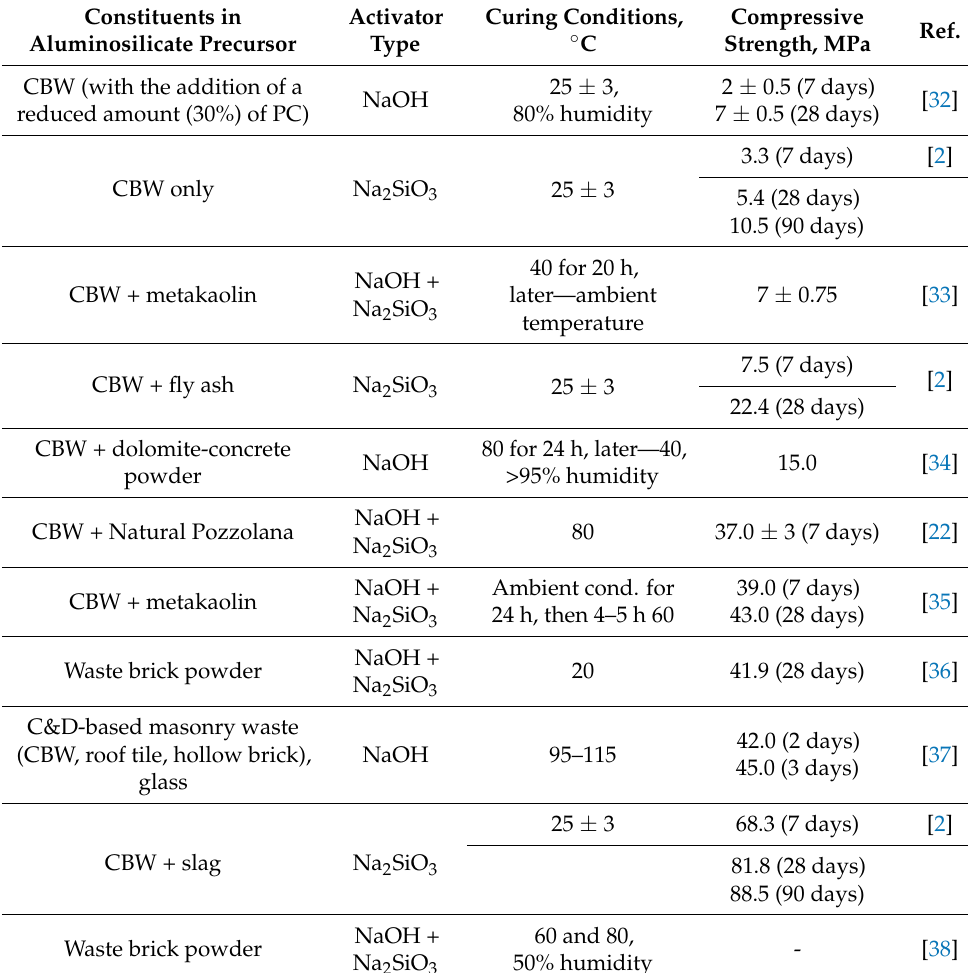
Table 1. CBW-based geopolymer material properties and curing